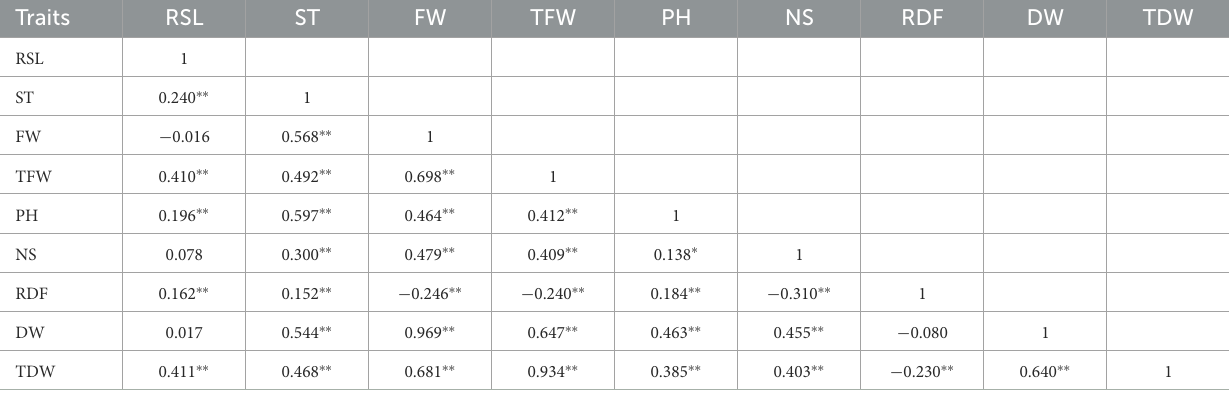
TABLE 6 Correlation coefficients of phenotypes ( rp ) among 44 varieties of alfalfa in 2019. Traits